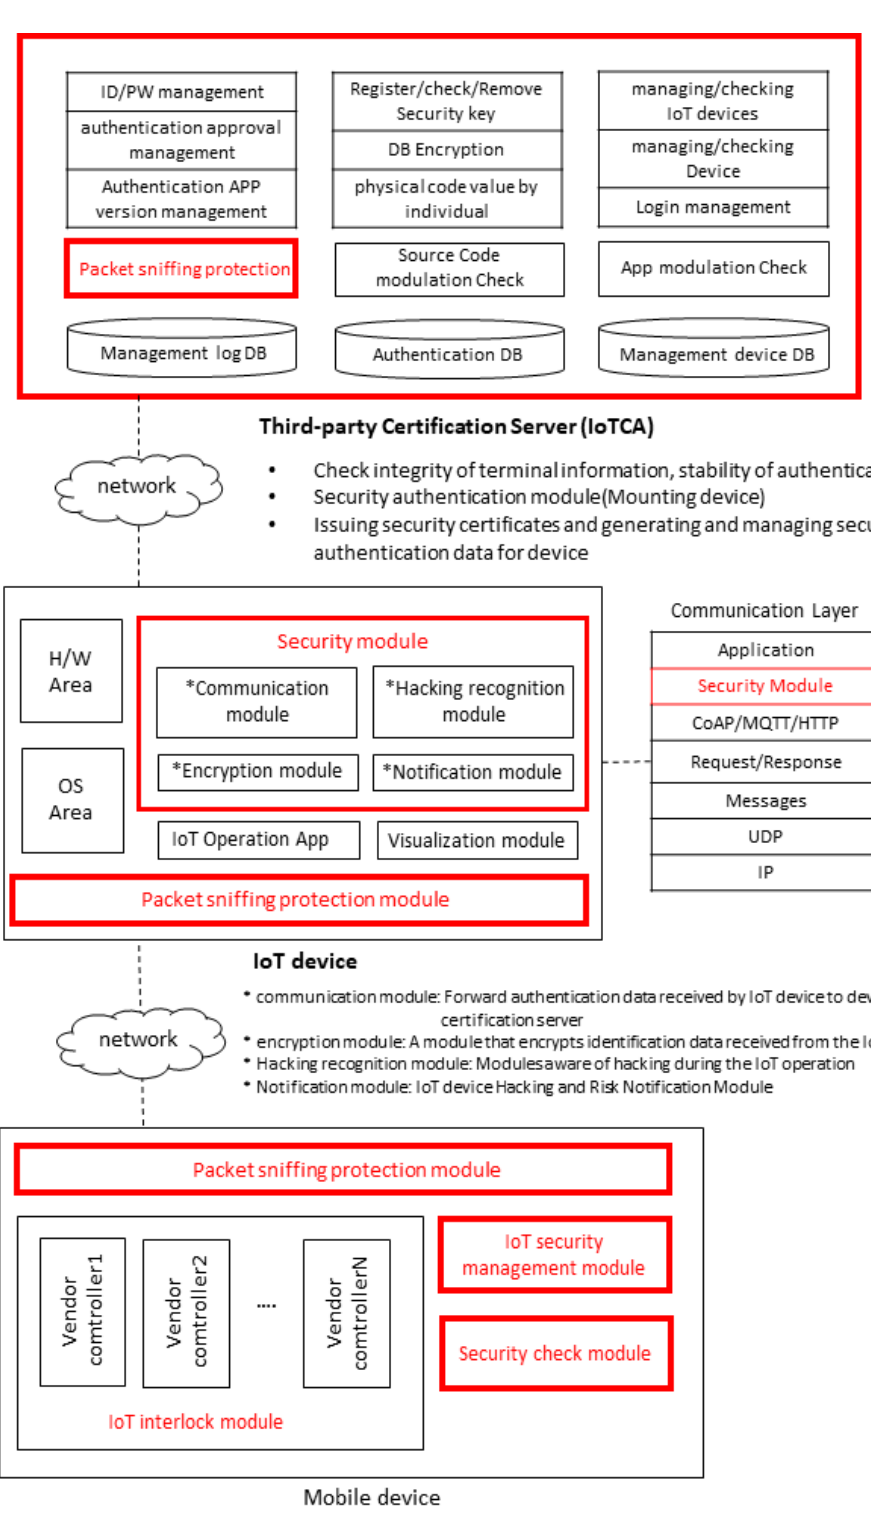
Figure 3. IoT Device Third-party (Things Certification Center) Security Certification System.